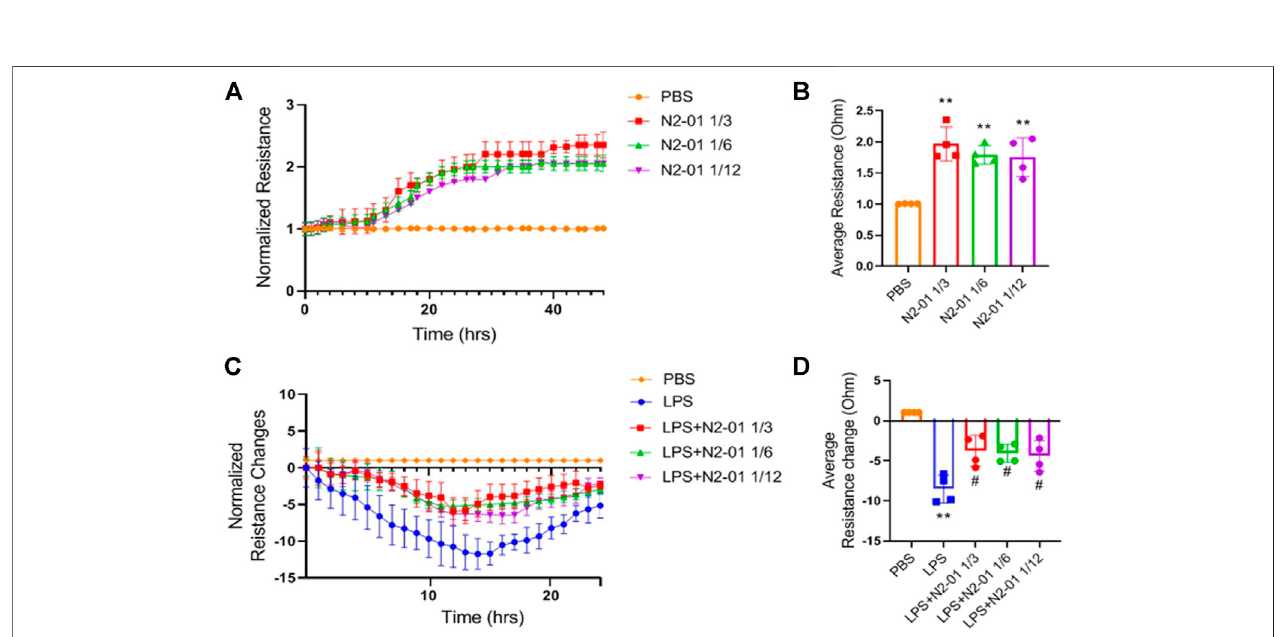
FIGURE9| EffectofN2-01onbarrierfunction.Endothelialcellswerepre-treatedwithN2-01for48 handthenstimulatedwithLPS(1 mg/ml)for24 h.Thecapacity of N2-01 torestore barrier functionin response toLPS hasbeen monitoredand recorded for24 h. (A) Line graph showing the measurementofresistance ofendothelial monolayer after N2-01treatmentat indicated doses. (B) Bar graphsshowthe dataofaverageresistance measurementscontinuously recordedforand at 48 h. (C) Line graph showing the measurement of resistance of endothelial monolayer after LPS treatment for 24 h. (D) Bar graphs show the data of average resistance measurements continuously recorded for and at 24 h. Data are presented as mean ± SD of four individual experiments (n (cid:2) 4). For (B) and (D) : ** p < 0.01 vs PBS; # p < 0.05 vs LPS.